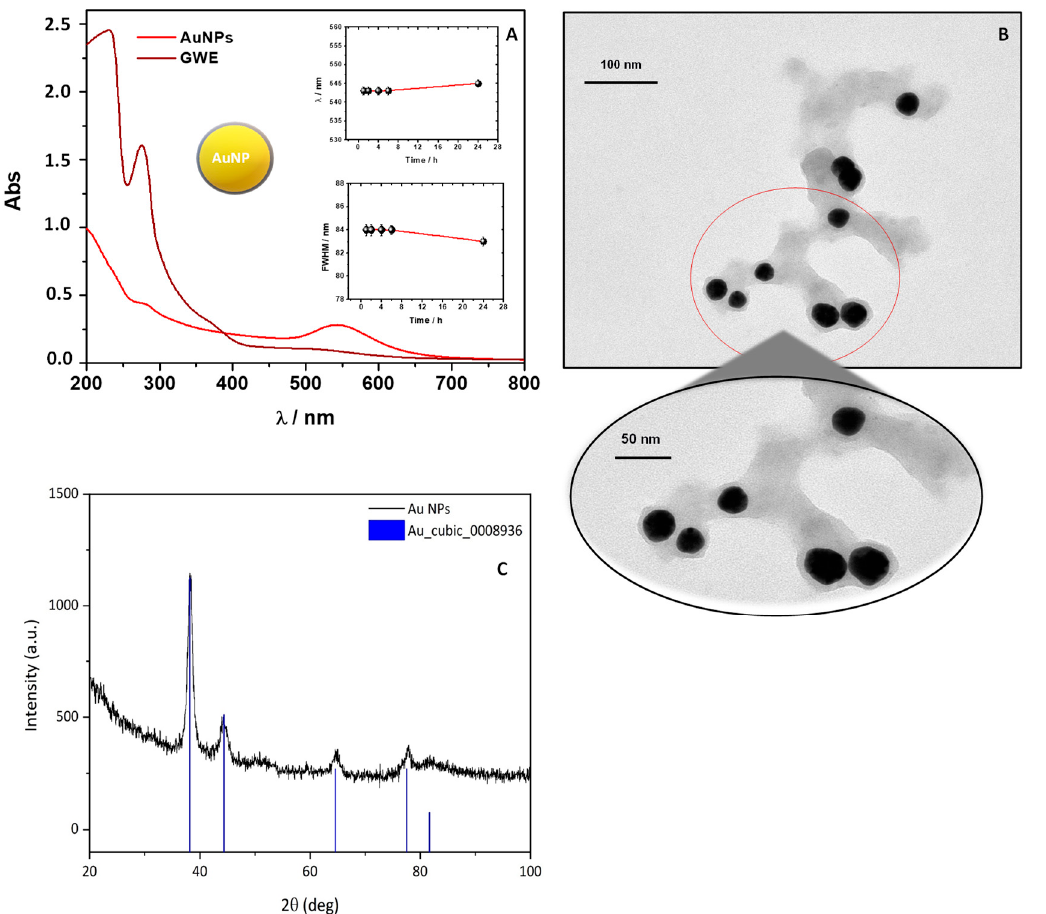
Figure 2. UV-Visible spectra of an AuNPs solution (dilution 1:5 from the stock solution), observing their typical SPR band ( A ). In the insets, the wavelength and FWHM time evolution registered in correspondence of the SPR are reported; TEM images of AuNPs at different magnification ratios ( B ); XRD diffraction patterns of AuNPs. Vertical bars: Bragg hkl reflections positions of the cubic Au crystal structure (ICSD code #044362) ( C ).